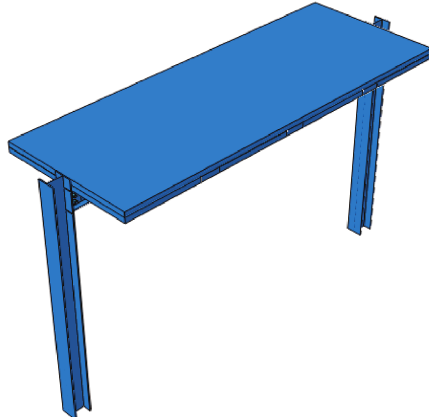
Figure 12: Numerical model of the composite beam